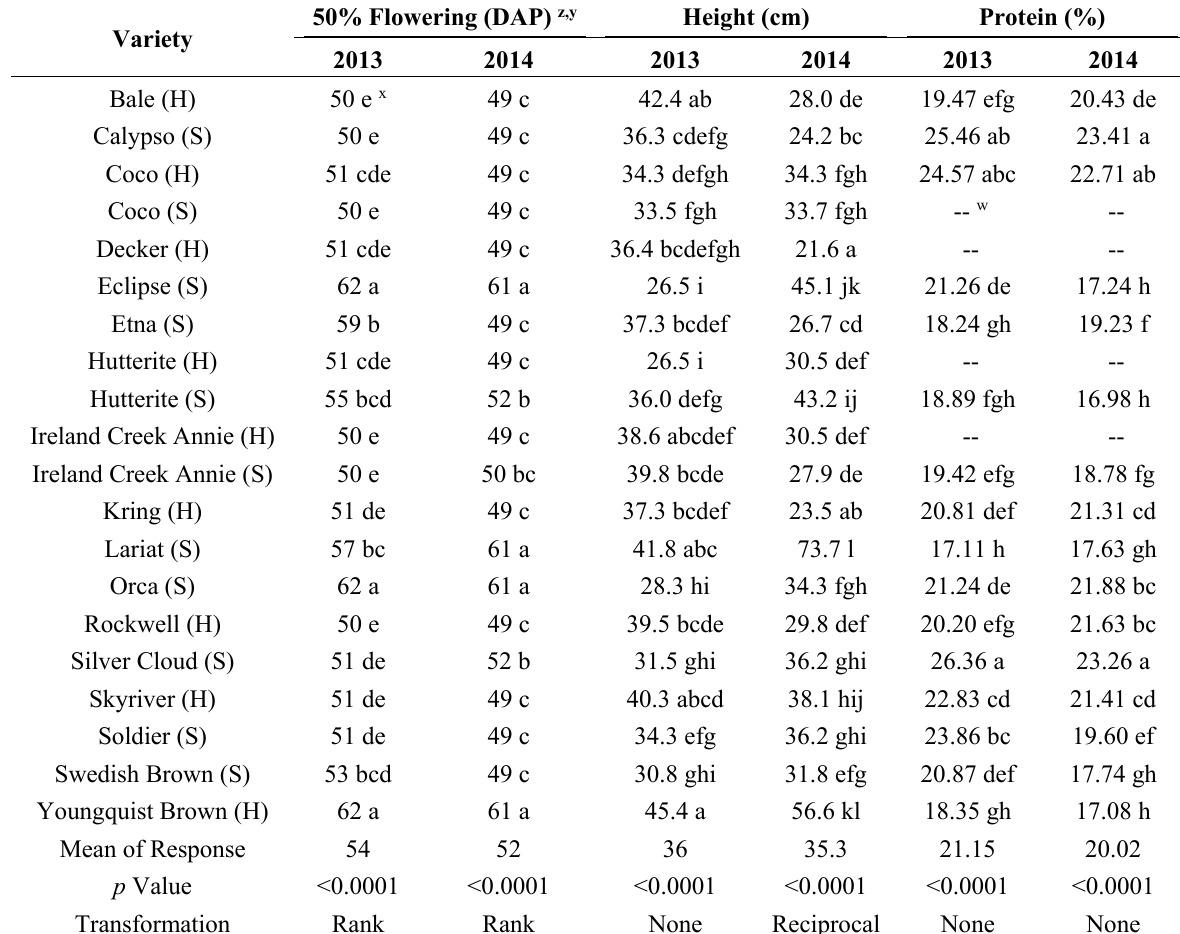
Table 3. Mean days after planting (DAP) to 50% flower, plant height (cm) at 50% flowering and protein content (%) of nine heirloom and 11 standard dry bean varieties grown at Washington State University Northwestern Washington Research and Extension Center, Mount Vernon, WA, USA, in 2013 and 2014. H, heirloom varieties; S, standard varieties.